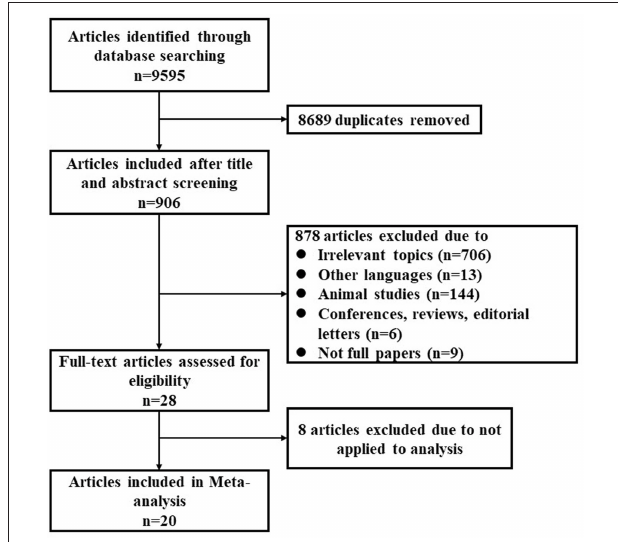
FIGURE 1 | Flow chart representation of literature search.